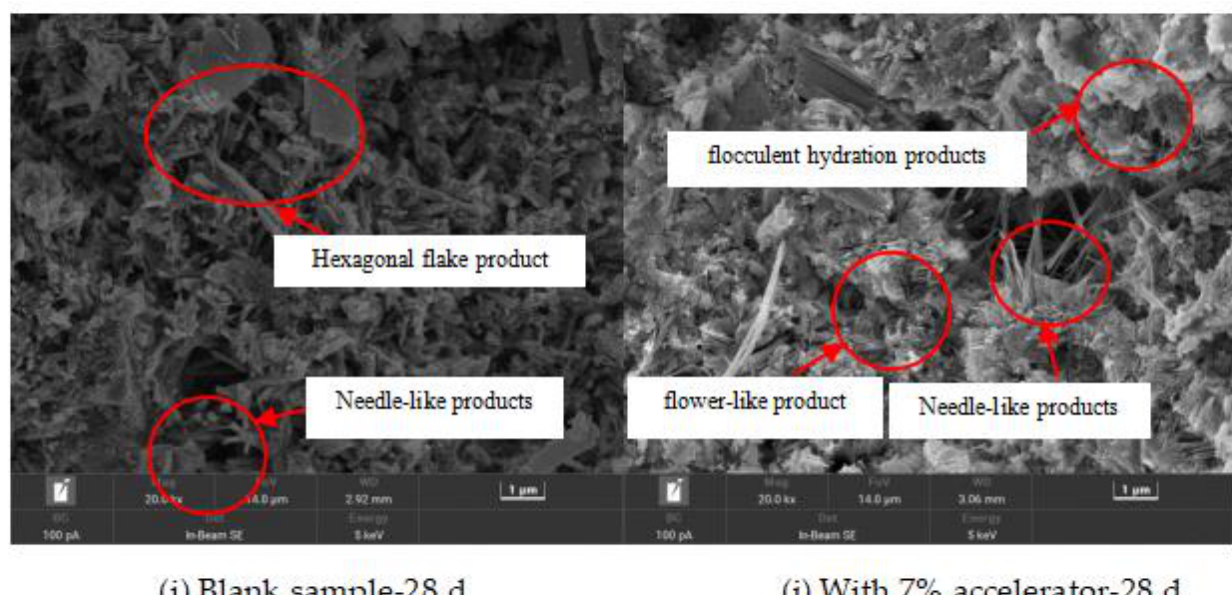
Figure 11. SEM images of specimens.